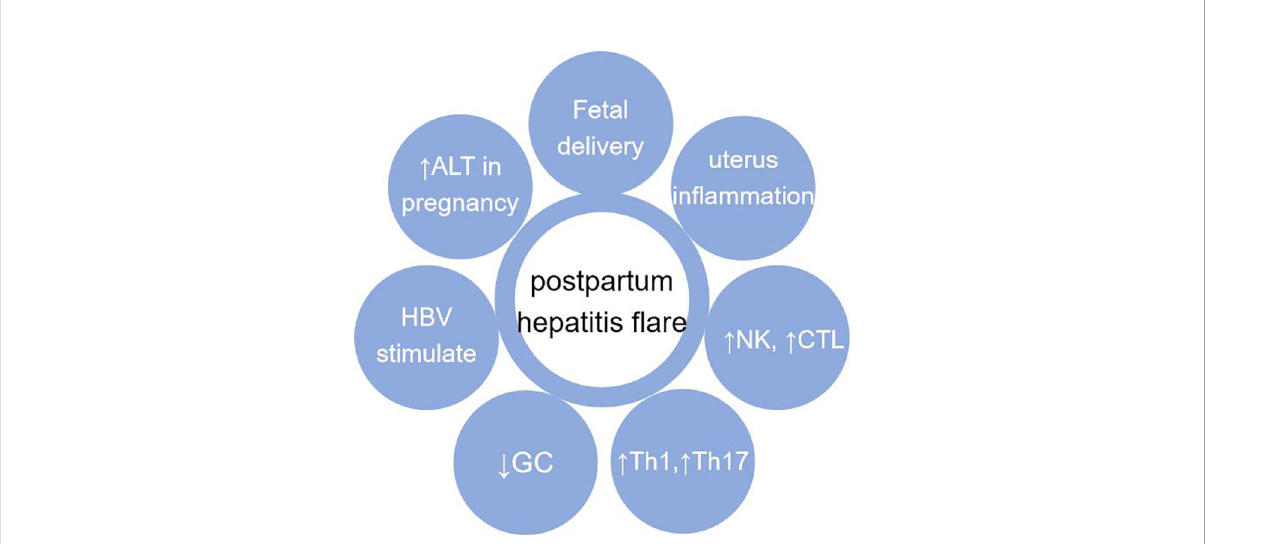
FIGURE 4 Causes of postpartum hepatitis. It mainly includes: fetal delivery (maternal fetal immune tolerance disappears);local in fl ammation of uterus after delivery; recovery of immune system after delivery; changes of Th1, Th2, Th17 and Treg balance after delivery; after delivery, GC decreases which is similar to “ hormone withdrawal ” reaction; HBV stimulation. Abbreviation: GC,